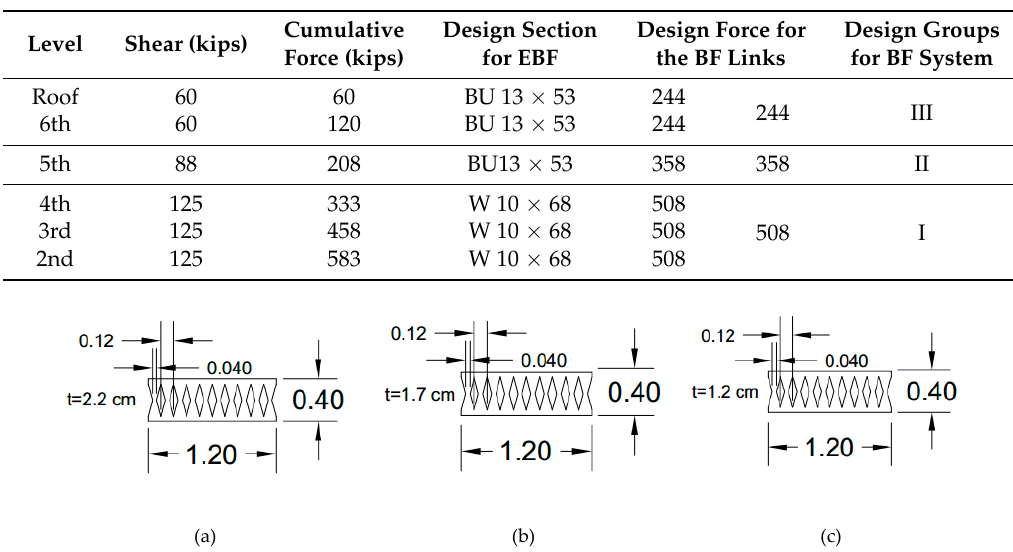
Figure 5. Three design groups used for incremental dynamic analysis (IDA) (thickness is in centimeters and the rest is in meters). ( a ) Category I, for lower story structural fuses based on W 10 × 68 beam dimensions; ( b ) Category II, for middle story structural fuses based on BU13 × 53 beam dimensions; ( c ) Category III, for upper story structural fuses based on BU 13 × 53 beam dimensions.